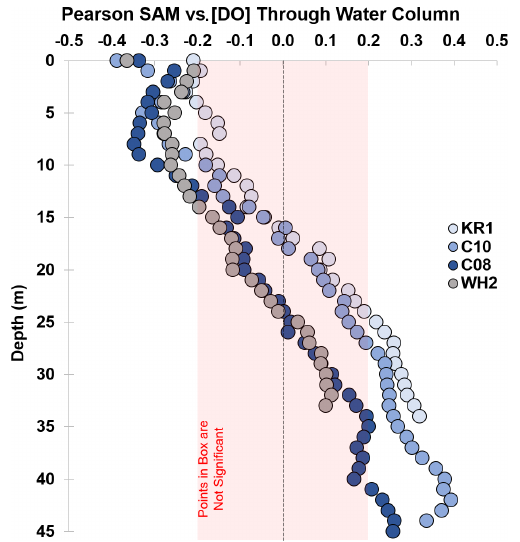
Figure 9. Pearson correlation coefficients ( r ) between Southern An- nular Mode (SAM) index and dissolved oxygen concentrations at KR1, C10, C08, and WH2 through the water column at 1m vertical resolution. The red box denotes statistically insignificant correla- tions, while all points outside of the box indicate statistically signif- icant correlations ( p< 0 . 05). Note points reference water depth and not height off